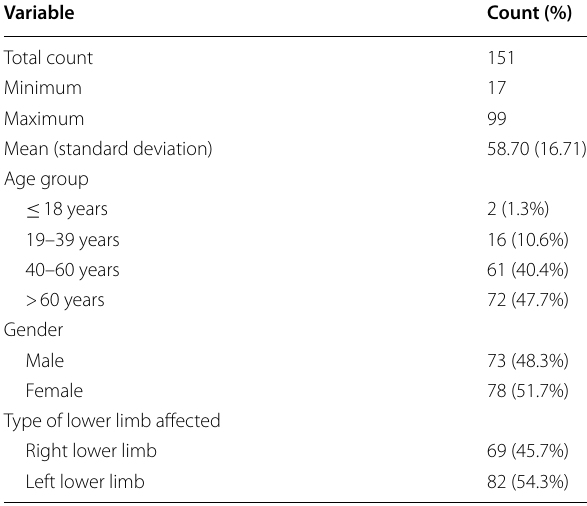
Table 1 Characteristics of